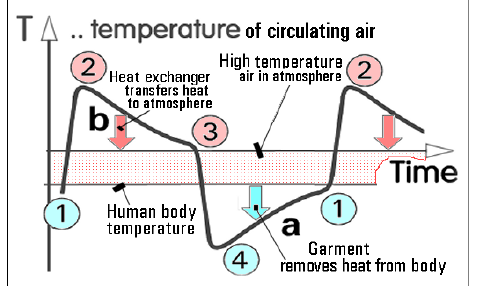
Fig. 3. The time dependence of air temperature according to Fig. 2. After being cooled by expansion in (3)-(4), the air in a . between (4) and (1) absorbs heat from wearer’s body. It is then heated by compression to discard the heat between (2) and (3).